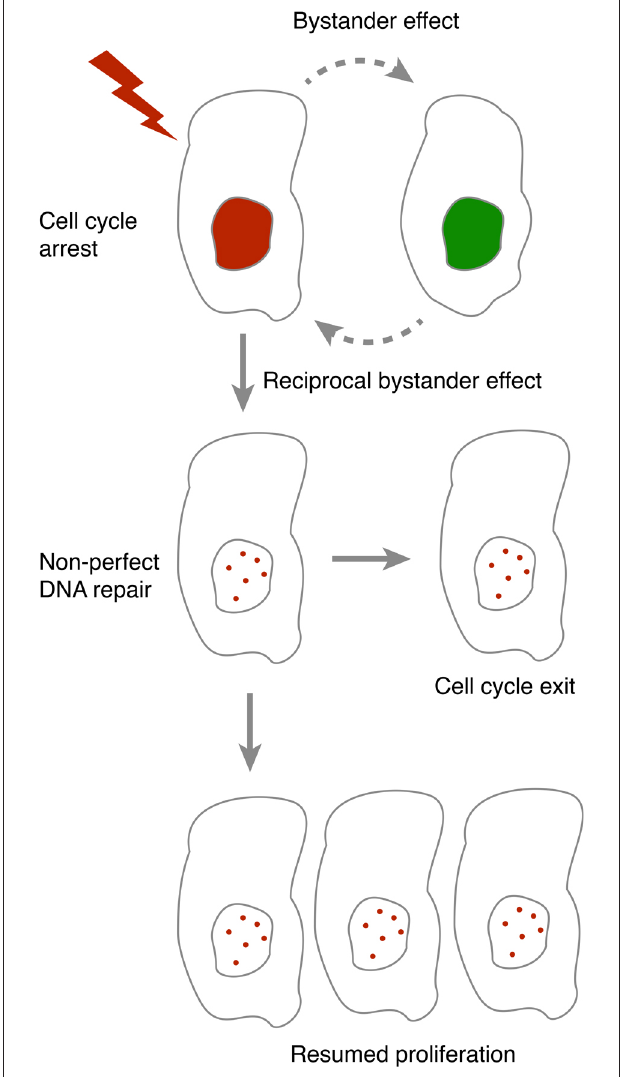
FIGURE 1 | In the presence of DNA damage, cells either pause or terminally exit the cell cycle. As DNA repair and cell cycle checkpoint maintenance are not always accurate, resumption of proliferation after a cell cycle pause may lead to propagation of mutations. Bystander communication forms an intercellular feedback that may contribute to whether resumption of proliferation may